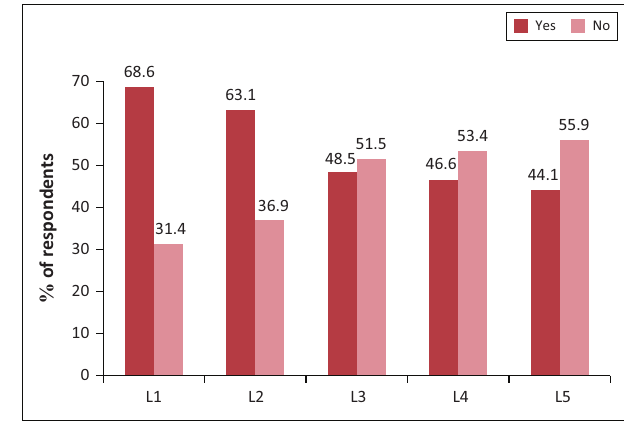
FIGURE 5: Value of capturing lessons learned. FIGURE 6: Leadership role in knowledge sharing.